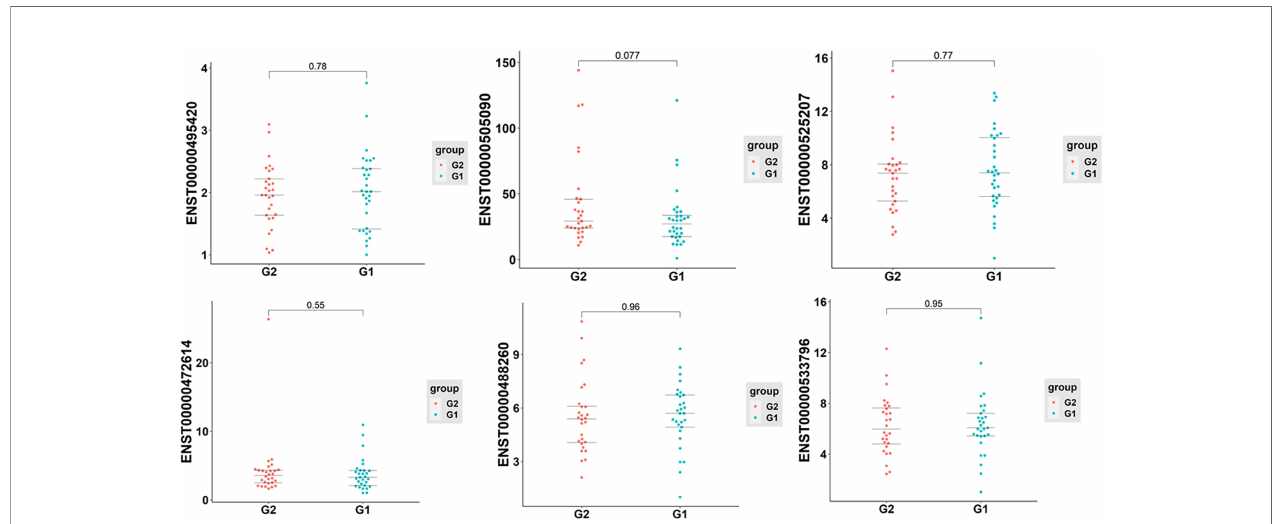
FIGURE 7 | The qRT-PCR analysis of selected six exosomal lncRNAs in T1DM and control subjects (T1DM subjects N=30; age-, sex- matched Control subjects N=30). G1: control group; G2: case